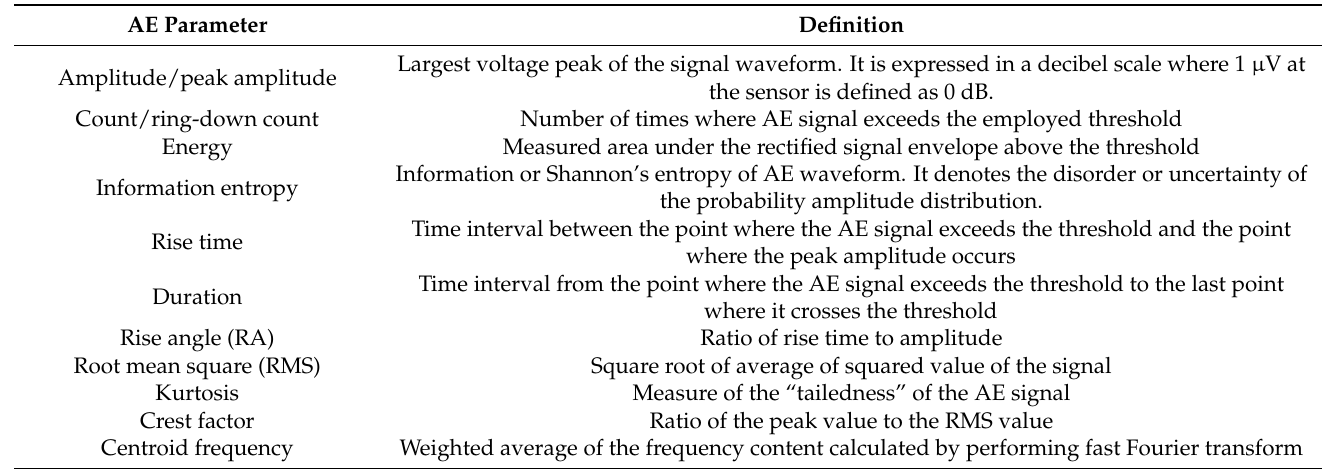
Table 1. Definitions of different AE parameters used in the present research